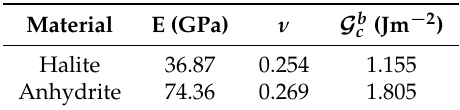
Figure 12. Salt rock composite specimen under uniaxial compressive loading. Geometry and boundary conditions, experimental failure pattern and numerical predictions. Table 1. Mechanical and fracture properties: halite and